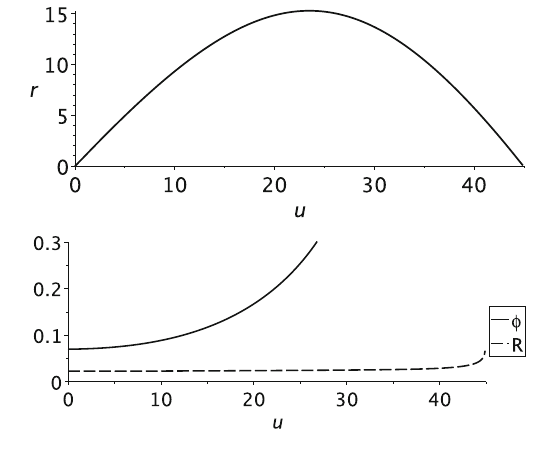
Fig. 2 The same as in Fig.1 but H = 0 . 035 , R ( 0 ) (cid:10) 0 . 0227767